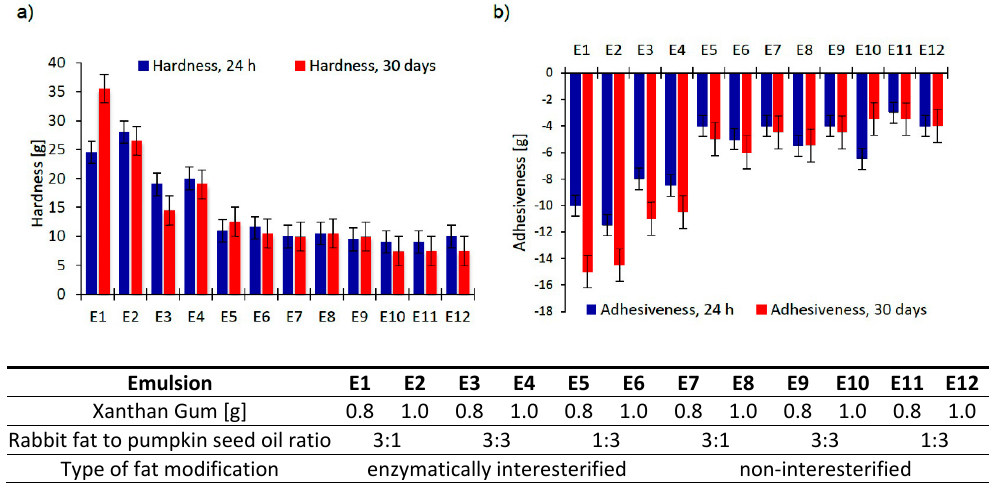
Figure 1. Texture parameters (( A ) hardness, ( B ) adhesiveness) for emulsions after 24 hours and 30 days from their preparation (as a mean value of three determinations ± SD).